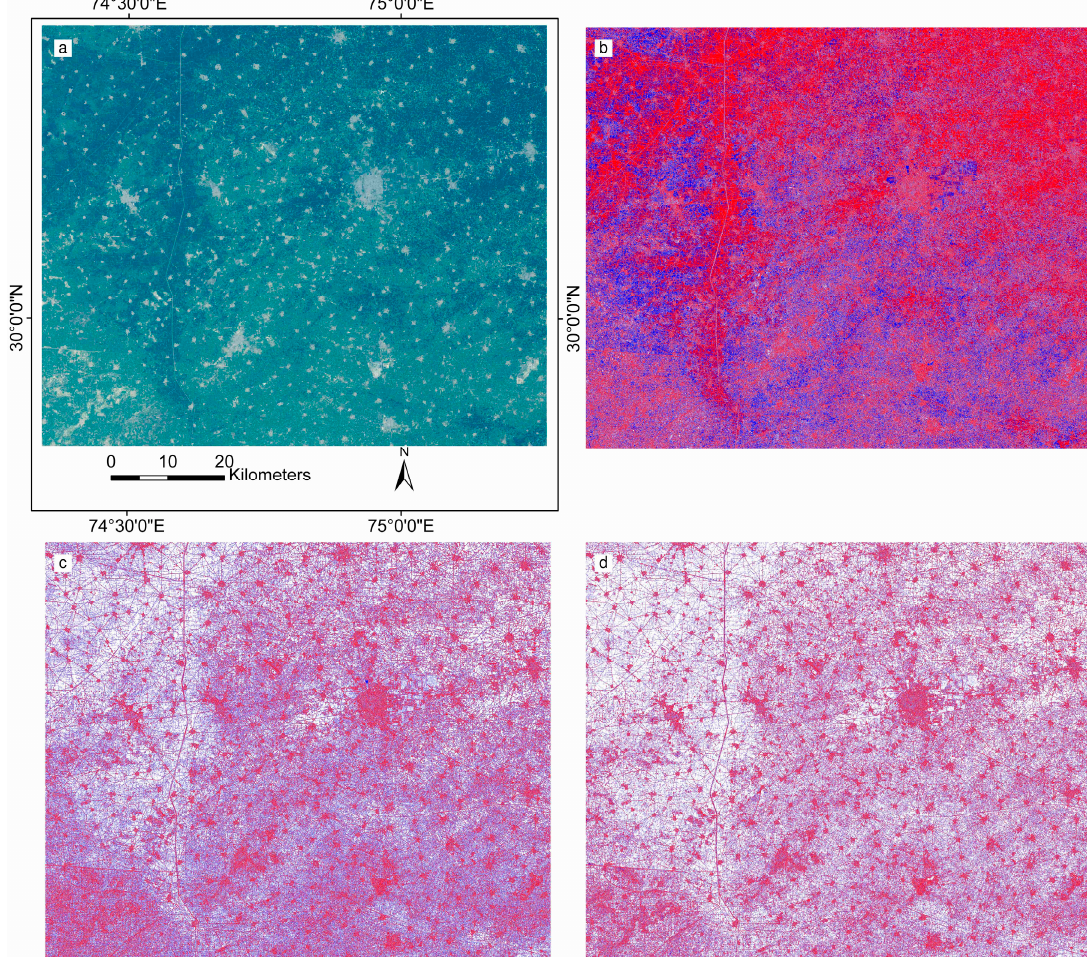
Figure 5. India 2970 × 2470 30 m Landsat 8 TOA red, green, blue TOA reflectance ( a ). Absolute reflectance differences between the 15 m panchromatic band and the 15 m resampled intensity images generated using: the equal spectral weights ( w red = w green = w blue = 1 { 3 ) ( b ); the spectral response function based (SRFB) spectral weights ( w red = 0.4030, w green = 0.5177, w blue = 0.0802) ( c ); and the image specific spectral weights w red = 0.4922, w green = 0.4586, w blue = 0.0512) ( d ). Absolute reflectance differences colored as: 0 ≤ white < 0.0035, 0.0035 ≤ blue < 0.0070, and red ≥ 0.0070. The 30 m true color and the 30 m intensity images were cubic convolution resampled to the 15m panchromatic band grid.